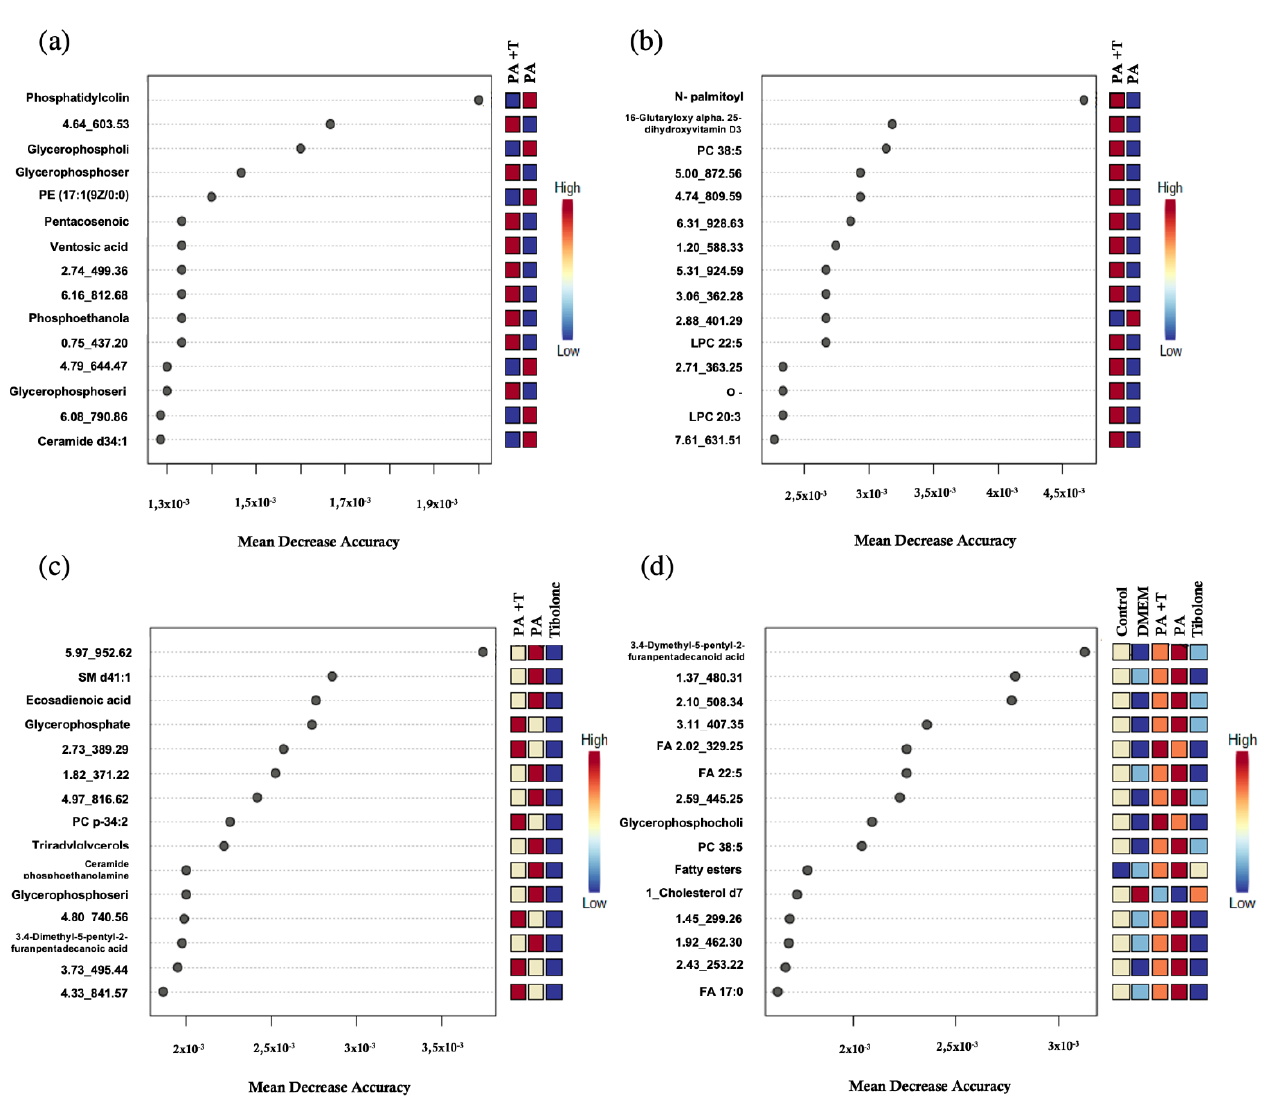
Figure 5. Random Forest for exometabolone analysis. ( a ) PA + T & PA ( b ) PA + T & T ( c ) PA + T & PA & T and ( d ) complete treatments. The list of the first 15 metabolites highlighted by their mean decrease accuracy value is presented for each evaluated treatment set. These metabolites have been reviewed in the literature and related to metabolic processes in humans within the present study. Table 1. List of annotated metabolites using CEU mass mediator for endometabolome. Metabolites written in italics were characterized only to chemical family